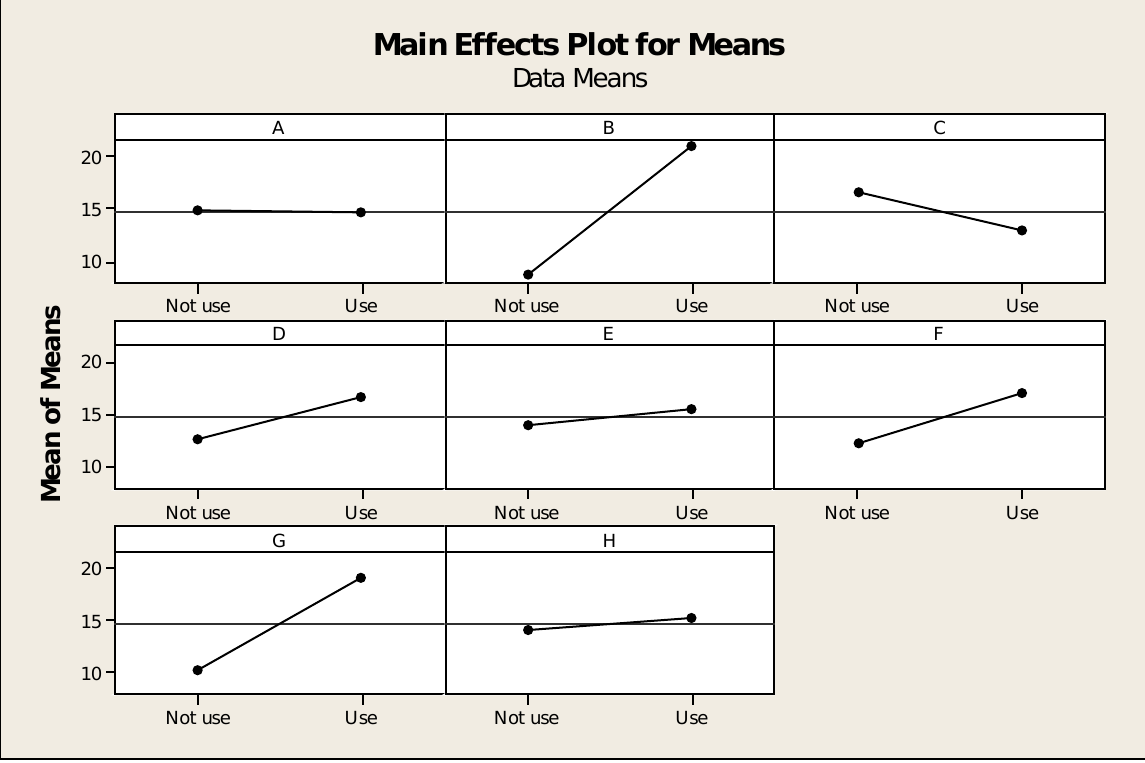
Fig. 1. Main Effect